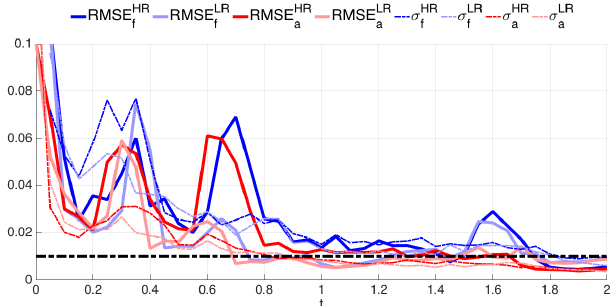
below and above the observational error standard deviation.